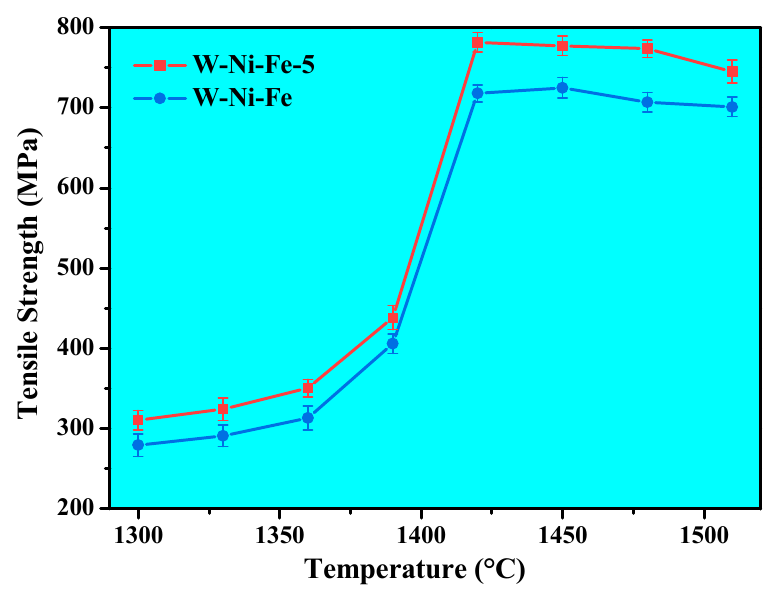
Figure 8. Tensile strength changing with sintering temperature.